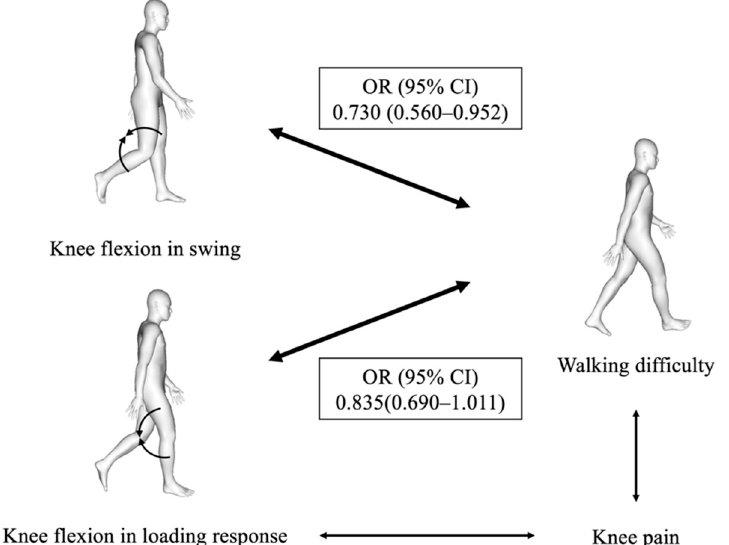
Figure 3. Graphical abstract of this study. Self-reported walking difficulty in Japanese patients with knee osteoarthritis was associated with the knee flexion excursion in the swing. The knee flexion excursion in the loading response is not related to the walking difficulty after controlling for the factor of knee pain. Odds ratios (OR) with their 95% confidence intervals (CI) are provided.